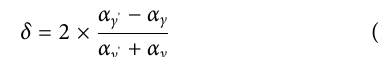
Frontiers in Materials |